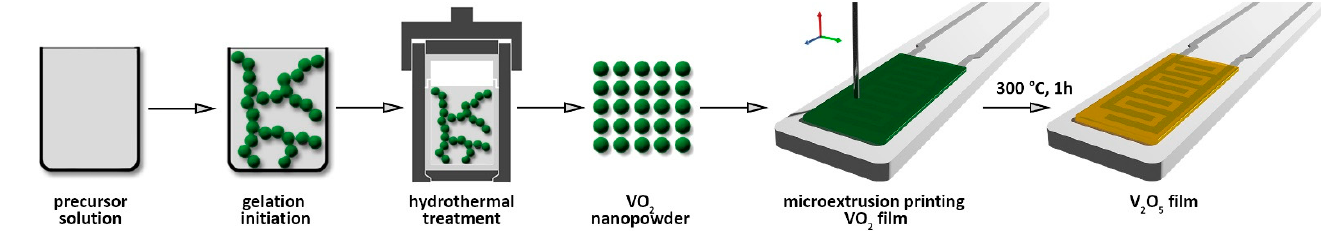
Figure 1. Scheme of V 2 O 5 powder and film preparation.